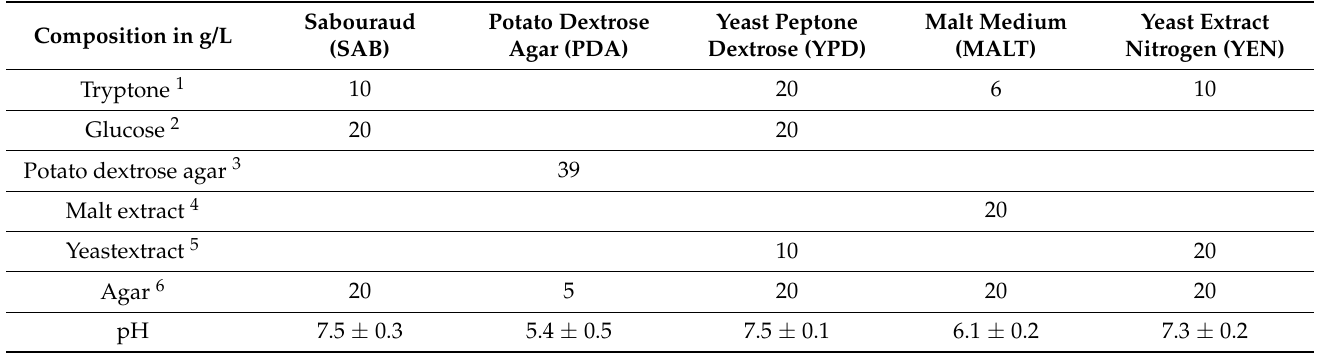
Table 2. Composition of agar media used in this